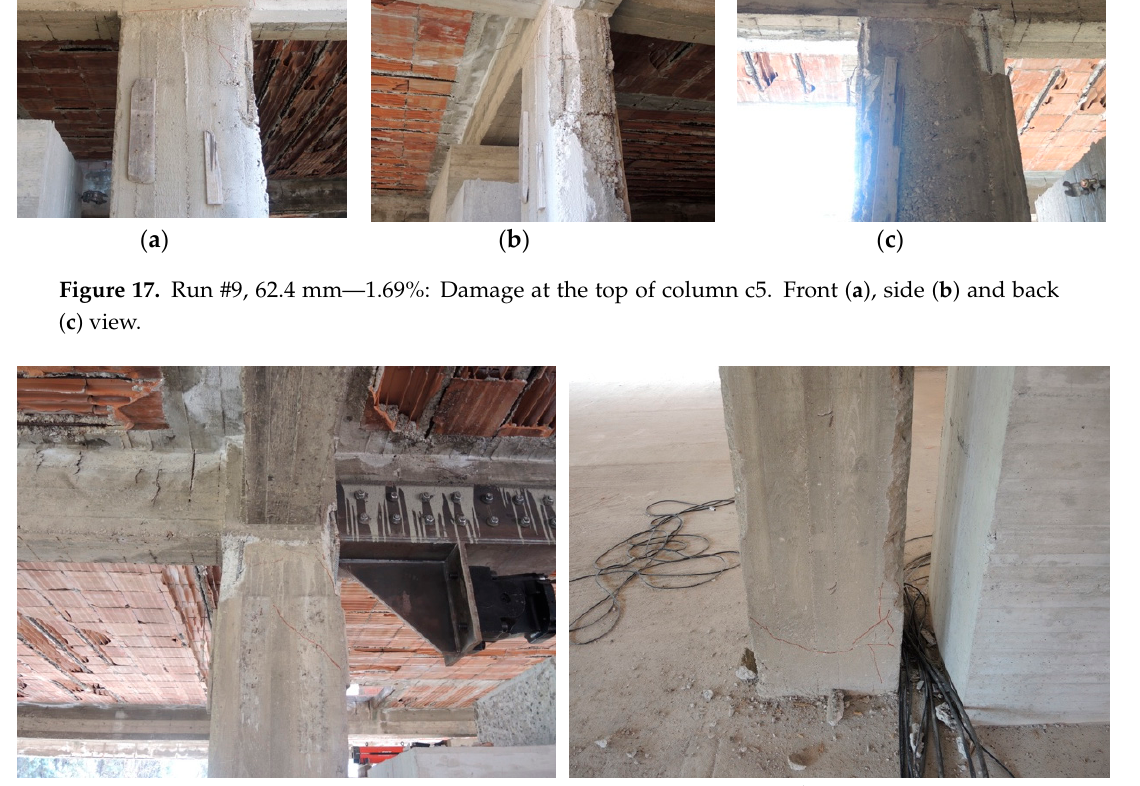
Figure 18. Run #9, 62.4 mm—1.69%: Damage at the top ( a ) and at the base ( b ) of column c11.